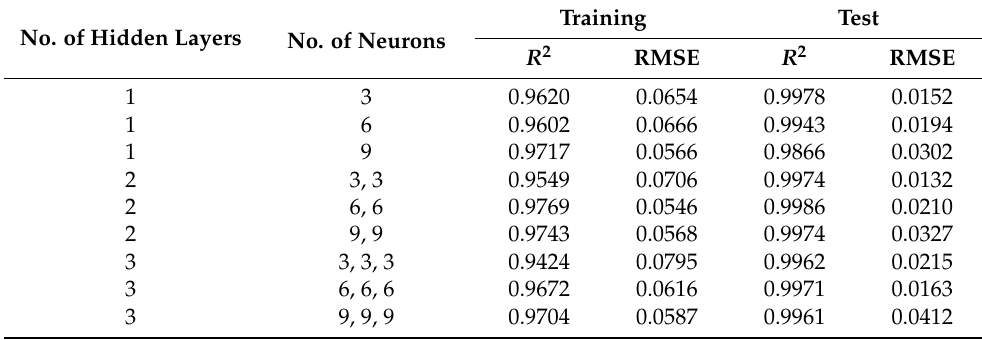
Table 4. Statistical results of drying kinetics of linden leaf samples for the ANN model using